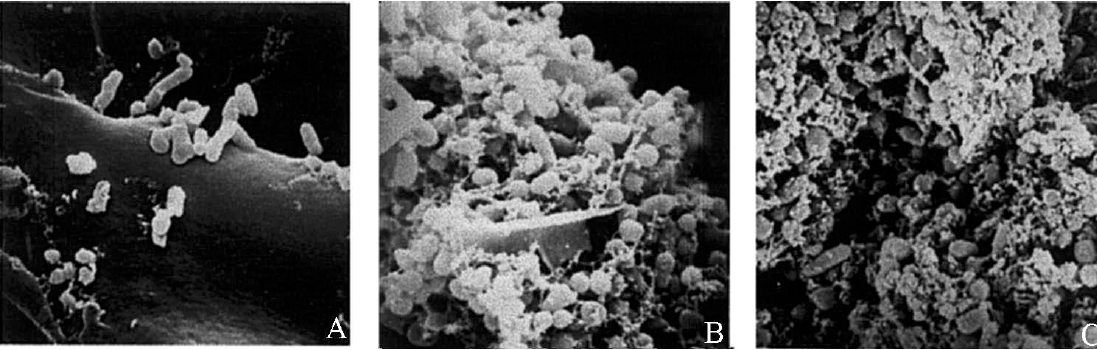
FIGURE 4. Biofilm formation of S. marcescens on synthetic polymer. (a) 24 h (b) 72 h (c) 96